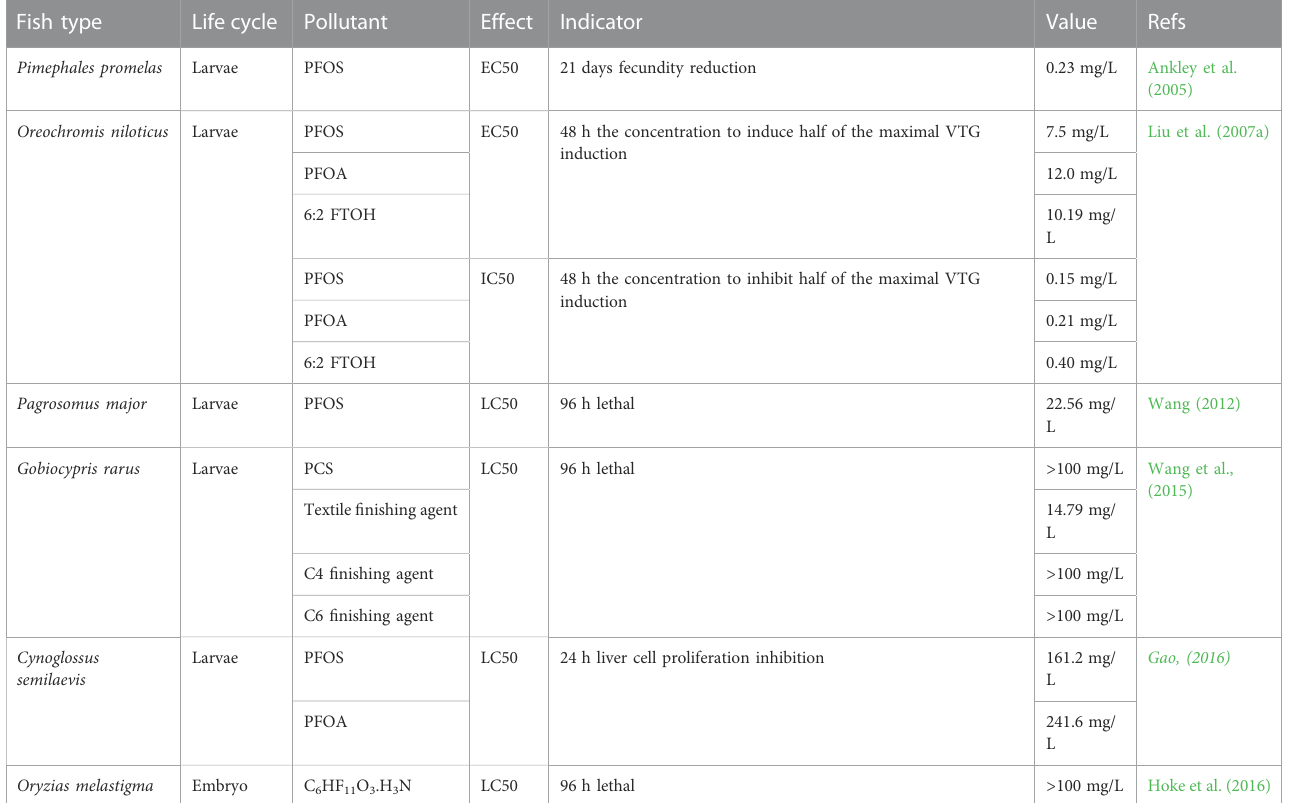
TABLE 2 EC50/LC50 values of target PFASs on other fi sh types. Fish